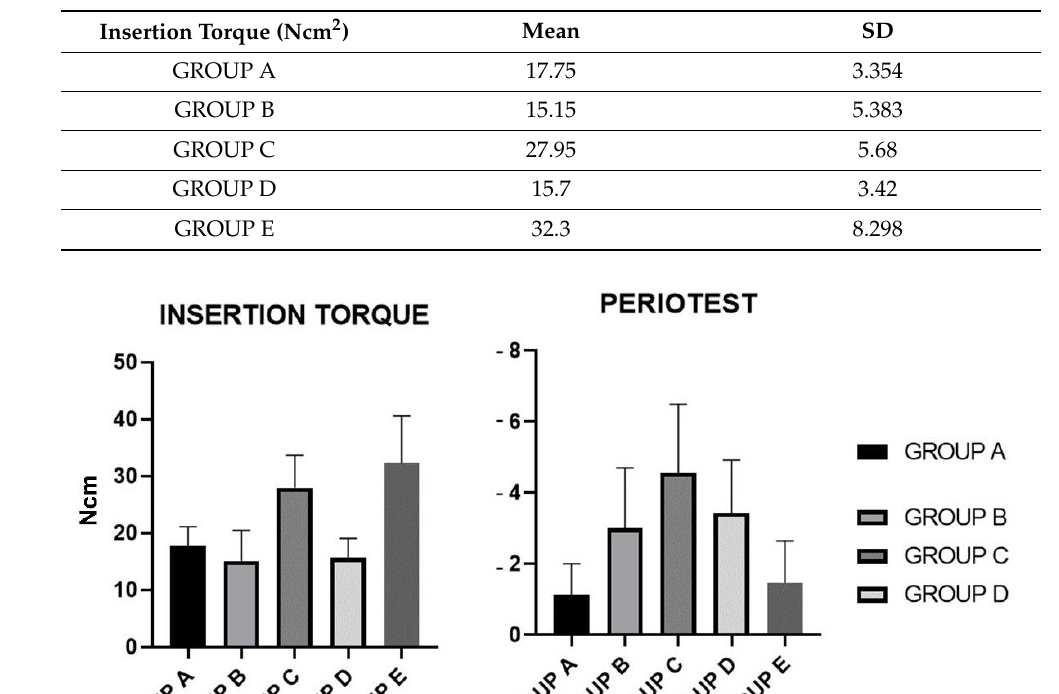
8.298 Table 1. Insertion torque means of the study groups.